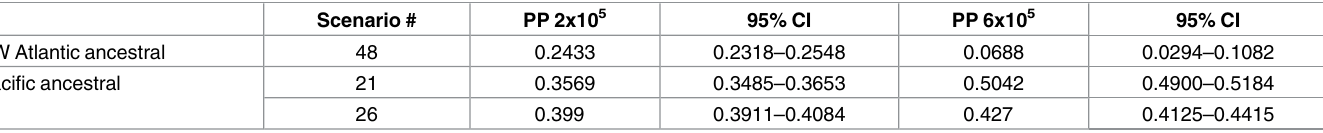
Table 5. Posterior probabilities and 95% confidence intervals (CI) for the most likely dispersal history scenarios when three equally likely scenar- ios (21, 26, 48) were compared against each other.